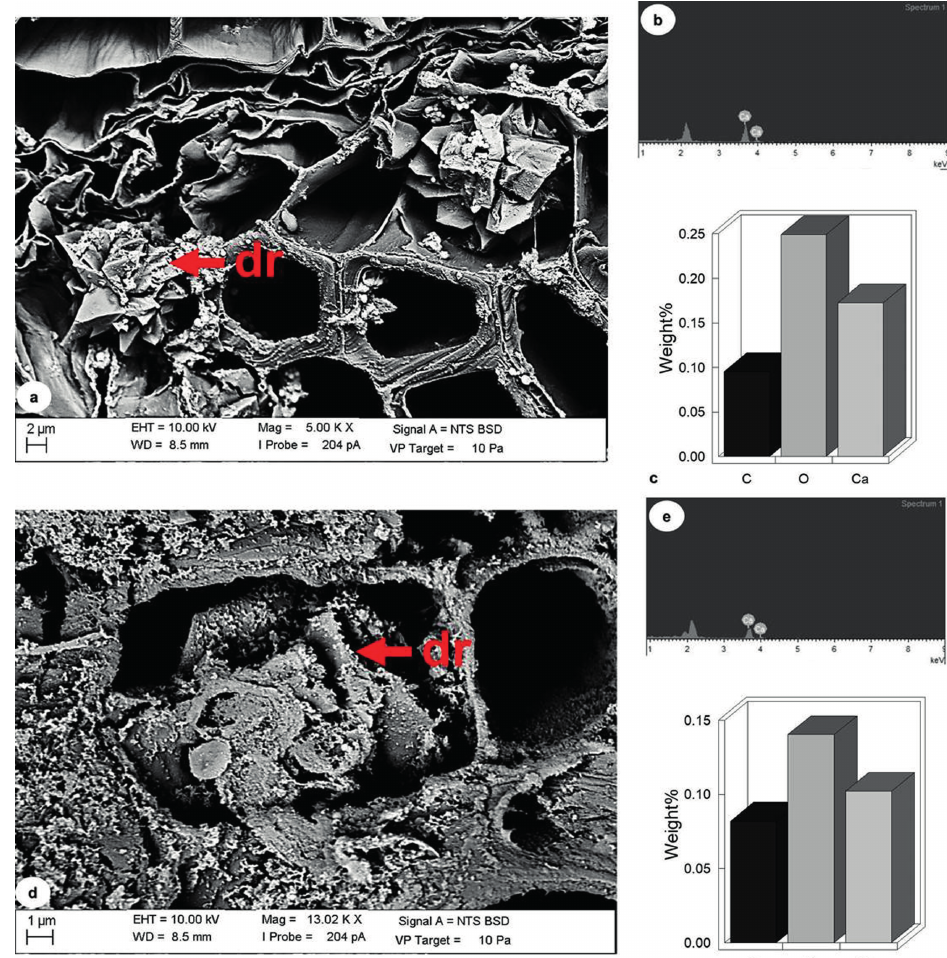
Figure 5 - Scanning electron micrograph and elemental composition of the druses observed in Artocarpus altilis and Artocarpus heterophyllus . a , b and c : A. altilis ; d , e and f : A. heterophyllus ; a and d : druses; b and e : analysis of elemental composition of the druses; c and f : percentage of the chemical constituents of the druses. Abbreviations: dr =